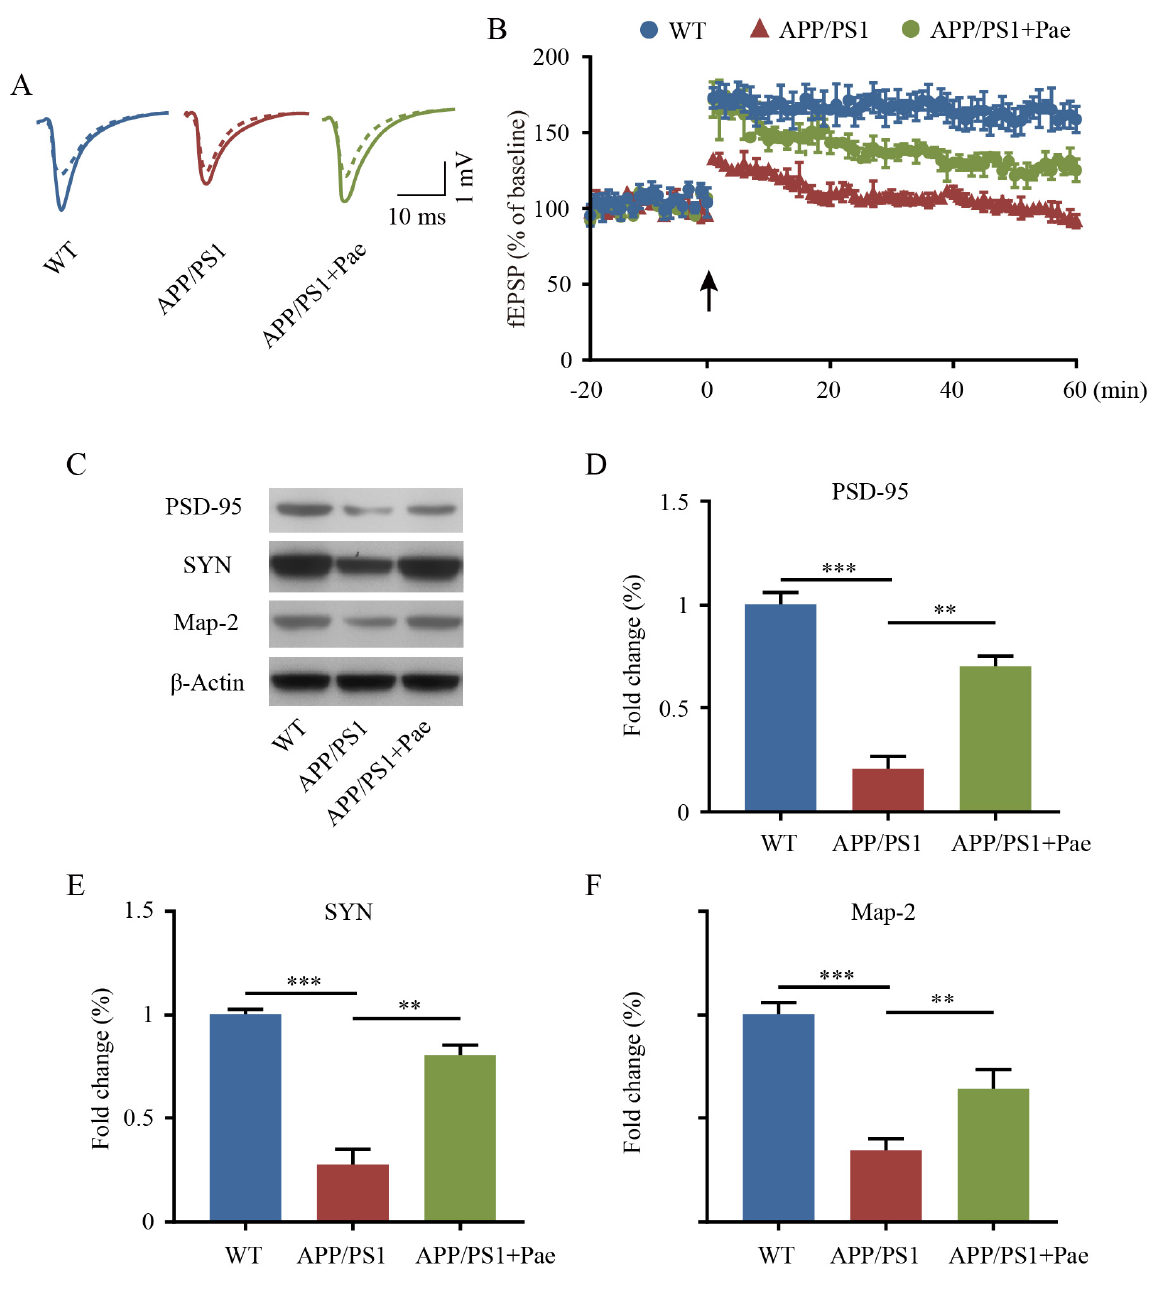
Fig.5. PaeonoladministrationpromotesynapticplasticityinAPP/PS1mice. (A) Traces of hippocampal LTP induced with high frequency stimulation. (B) Normalized fEPSP slopes of HFS-induced LTP. (C–F) Representative immunoblots and the relative levels of PSD-95, SYP, and MAP-2. Mean ± SEM was shown (n = 5 mice). ** p < 0.01, *** p <